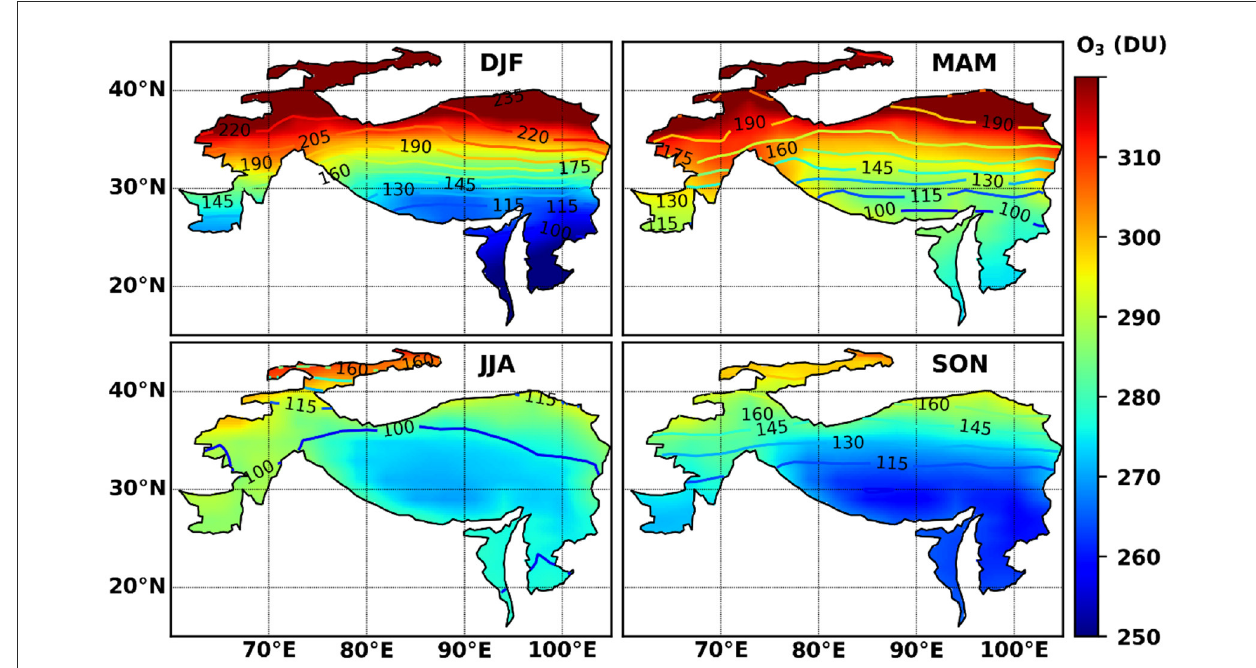
FIGURE2 Seasonal mean TCO (DU) distribution in TP. The seasons are defined as spring: March–April–May (MAM), summer: June–July–August (JJA), autumn: September–October–November (SON), and winter: December–January–February (DJF). The overlaid contours show the climatology of tropopause pressure.